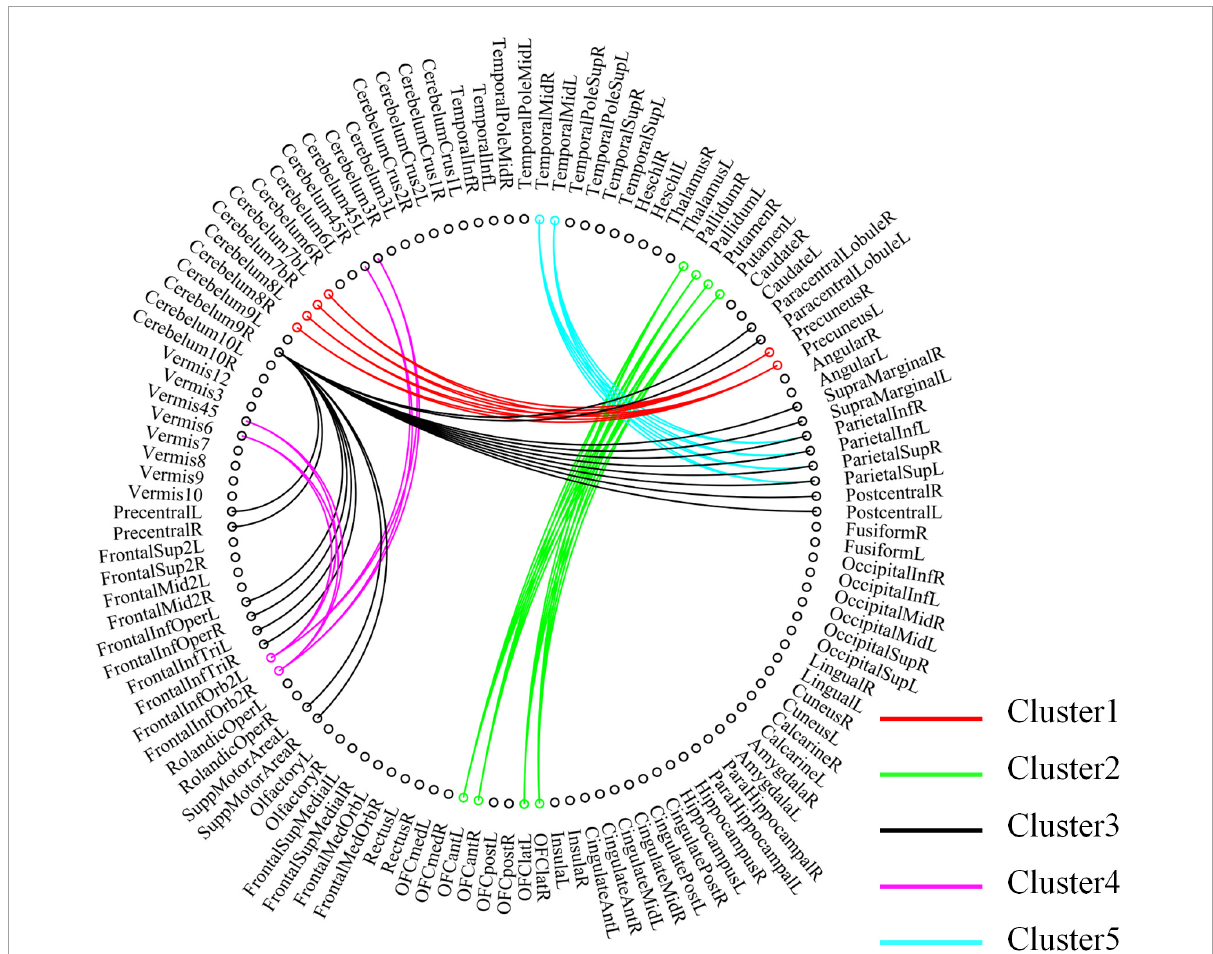
FIGURE10 Functional connectivity contained in the five clusters with the largest classification weights. Each node in the figure represents a ROI, and the line between the two nodes represents functional connectivity. The functional connections contained in different clusters are shown in different colors, and the importance increases sequentially from Cluster 5 to Cluster